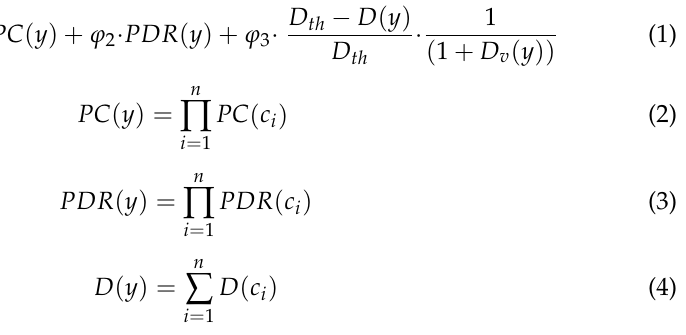
Figure 2. Neural network procedure for the VANET protocol boosted with the ACO algorithm.